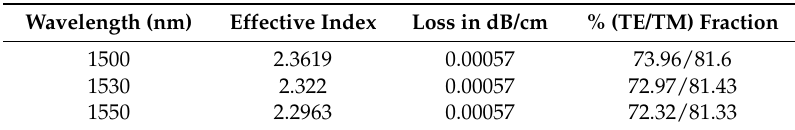
Table 3. SOI waveguide parameter.